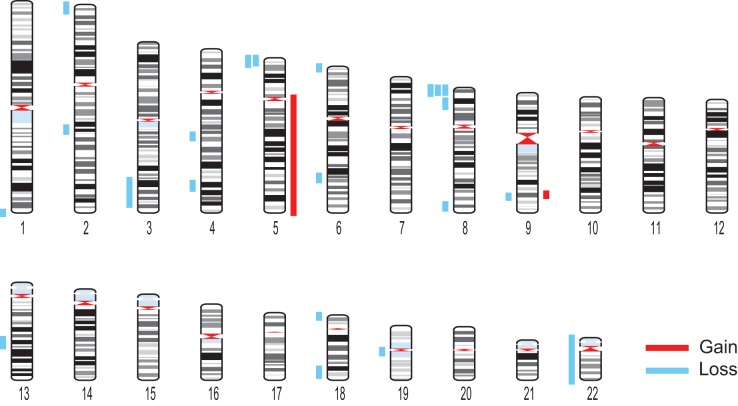
Megabase-scale CNVs in somatic cells. Karyogram showing the 23 gains and losses identified across 80 brain cells and 52 skin cells with VS <0.26. Gains and losses are represented by red and blue bars, respectively.